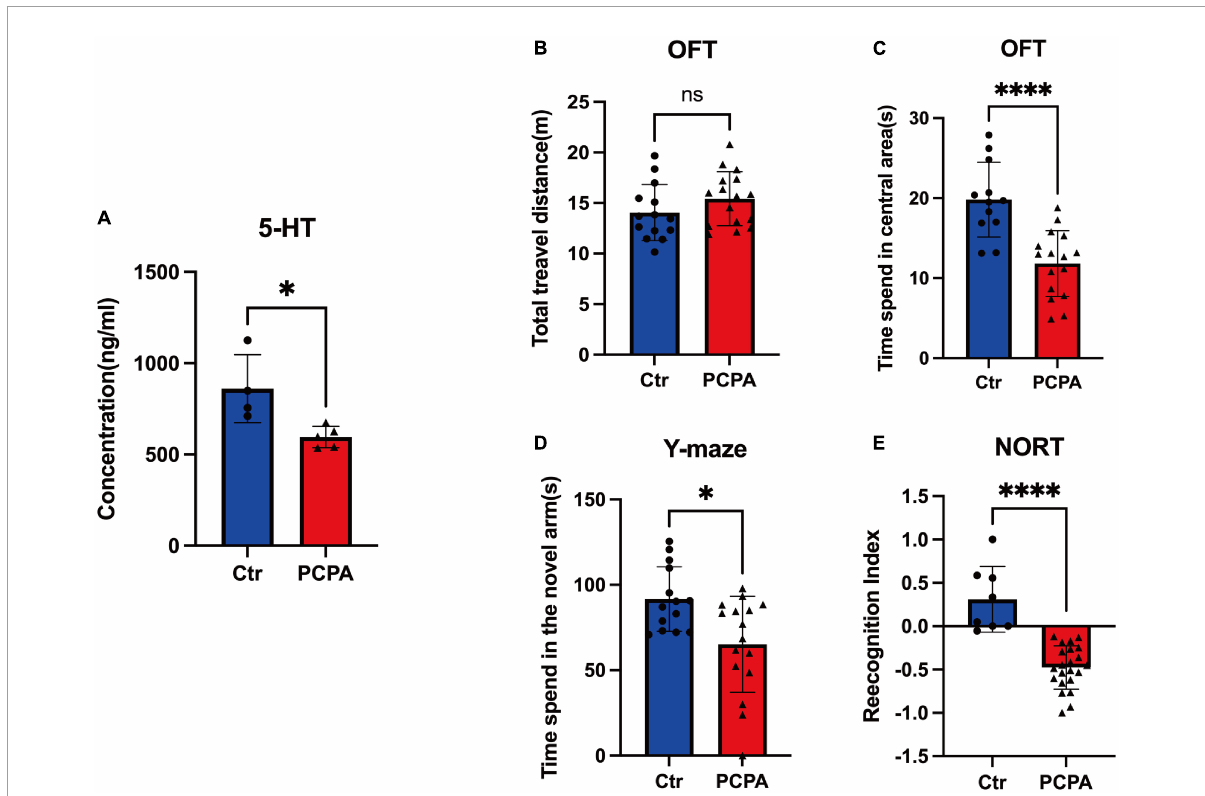
FIGURE1 Para-chlorophenylalanine (PCPA) treatment induced cognitive dysfunction and depression-like behavior in mice. (A) Concentration. (B) Total travel distance of open field test (OFT). (C) Time spent in the central area of OFT. (D) Time spent in the novel arm of the Y-maze test. (E) Recognition index of novel object recognition test (NORT). Data are presented as the mean ± SEM. * P < 0.05; **** P < 0.0001; ns, not